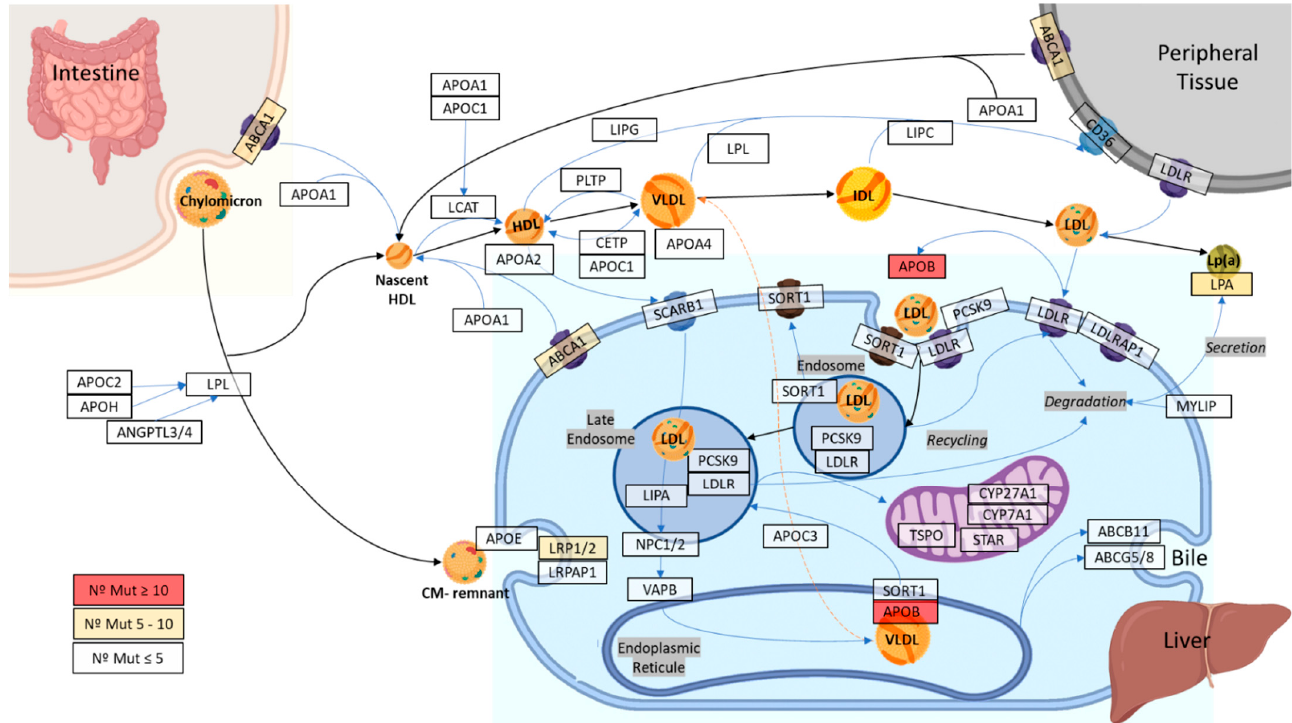
Figure 1. Schematic view of the 40 selected genes in the cholesterol metabolism pathway.